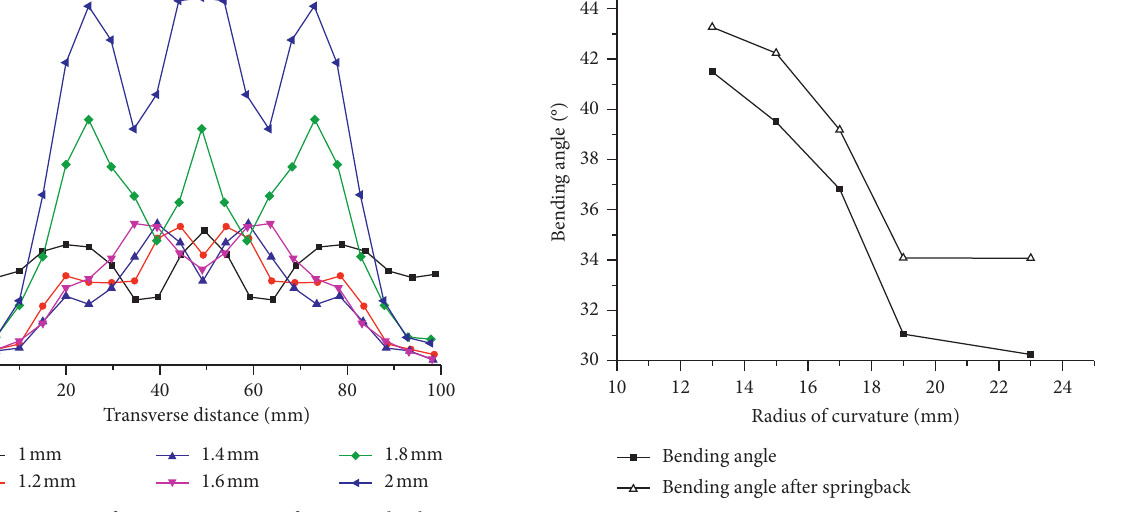
Figure 17: Curves of von Mises stress after